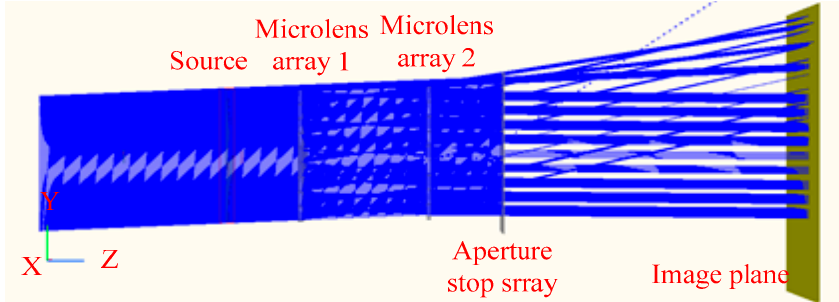
Figure 5. Schematic diagram of an example microlens array scanning imaging system (Y axis, δ = − 2°, θ = − 0.5°).